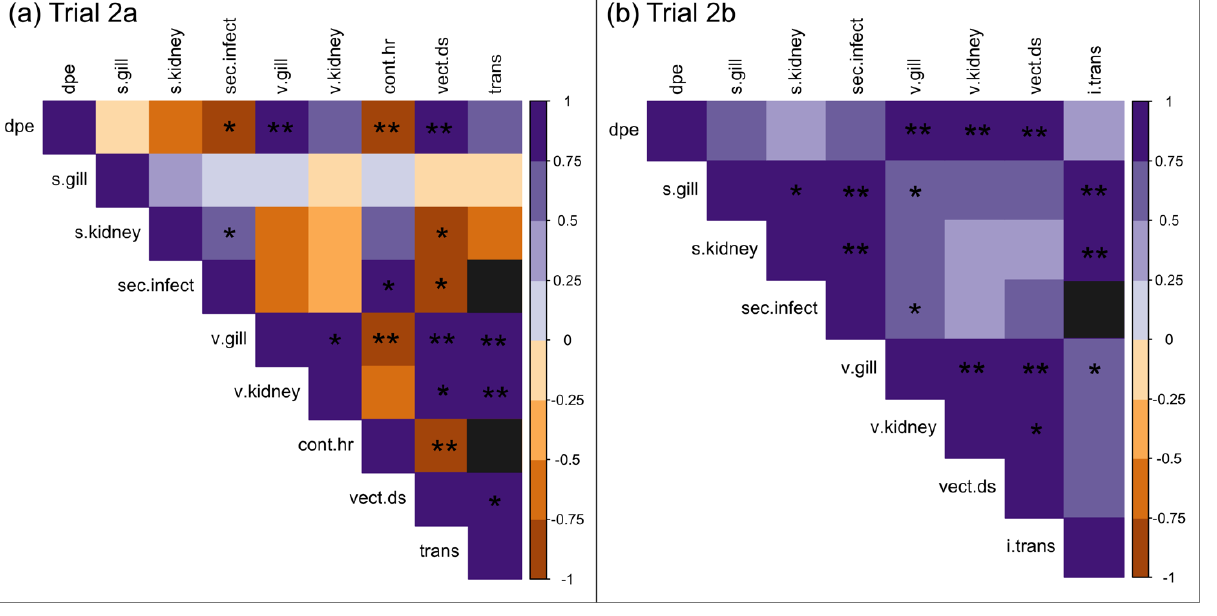
Figure 5. Correlation plots for continuous variables measured in ( a )Trial 2a/( b )Trial 2b. Dpe = days post exposure, s.gill = log viral load in s.carp gill tissue, s.kidney = log viral load in s.carp kidney tissue, sec.infect = number of secondary infections, v.gill = log viral load in v.carp gill tissue, v.kidney = log viral load in v.carp kidney tissue, cont.hr = average number of contacts per hour, vect.ds = vector disease scores, trans = transmissibility, i.trans = transmissibility not attributable to direct transmission (i.e., indirect transmission). Purple shades indicate magnitude of positive correlations. Orange shades indicate magnitude of negative correlations. * = p < 0.05, ** = p < 0.001.